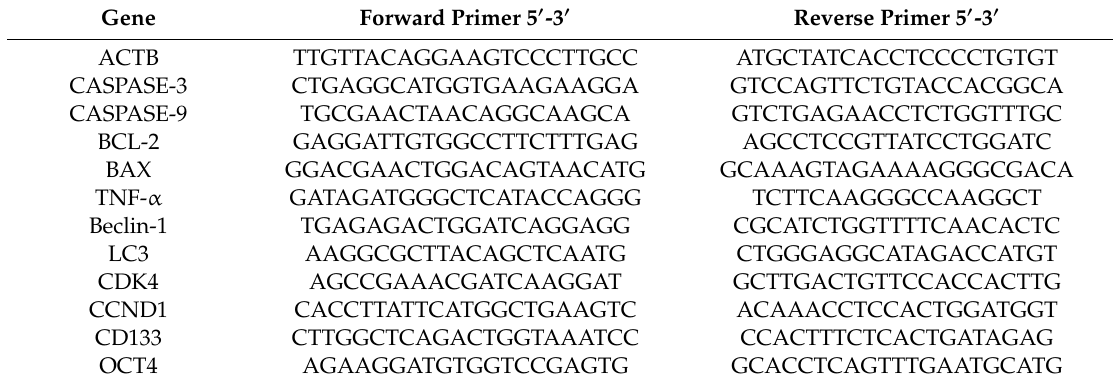
Table 1. Primer sequences used for RT-qPCR.